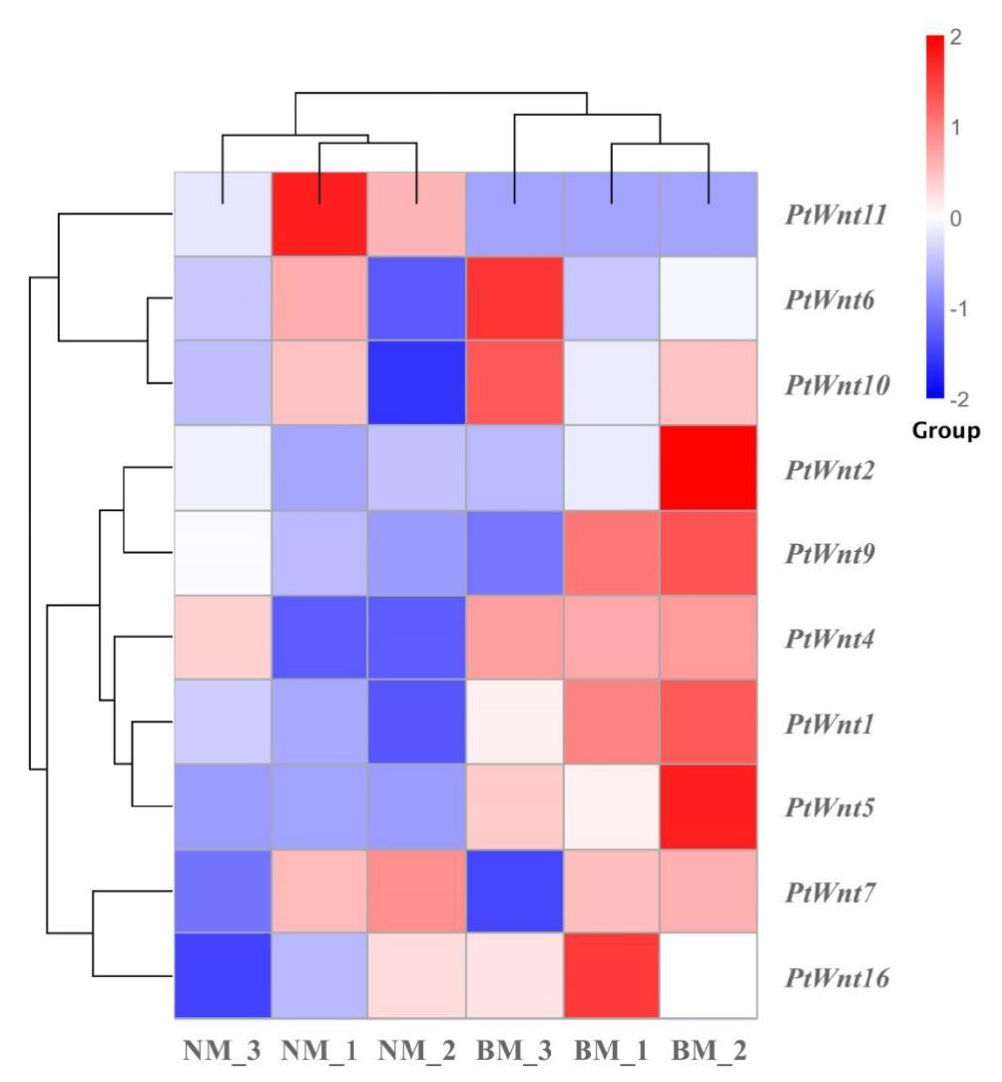
Figure 6. Heatmap of PtWnt gene expression profiles in regenerating limb bud muscle (BM) and normal limb muscle (NM).